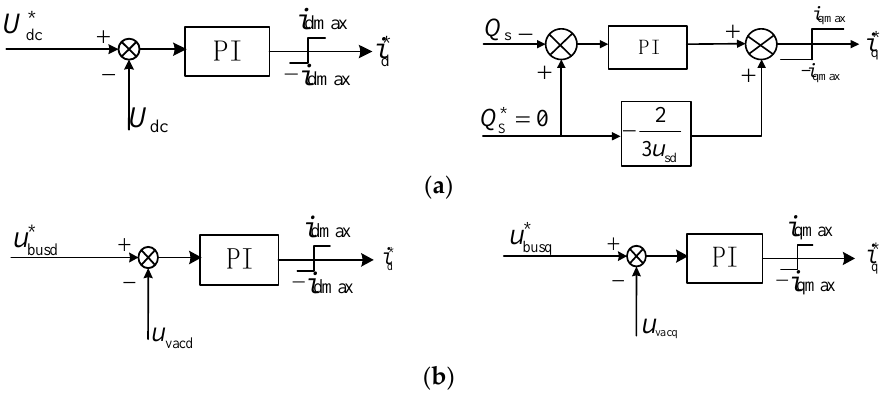
Figure 4. Schematic diagram of the MCAT outer loop control: ( a ) MMC H, N +1 to MMC H,2 N and LVM; ( b ) MMC H,1 to MMC H, N